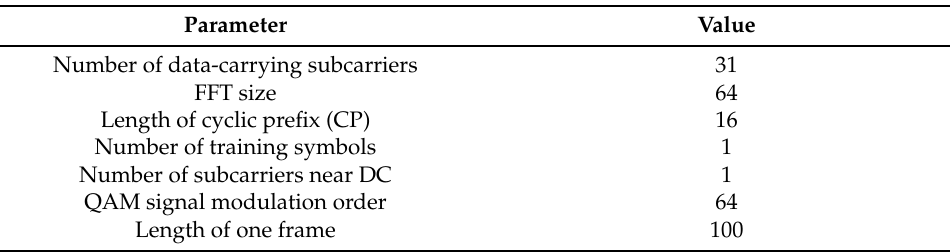
Table 1. Parameters of OFDM.